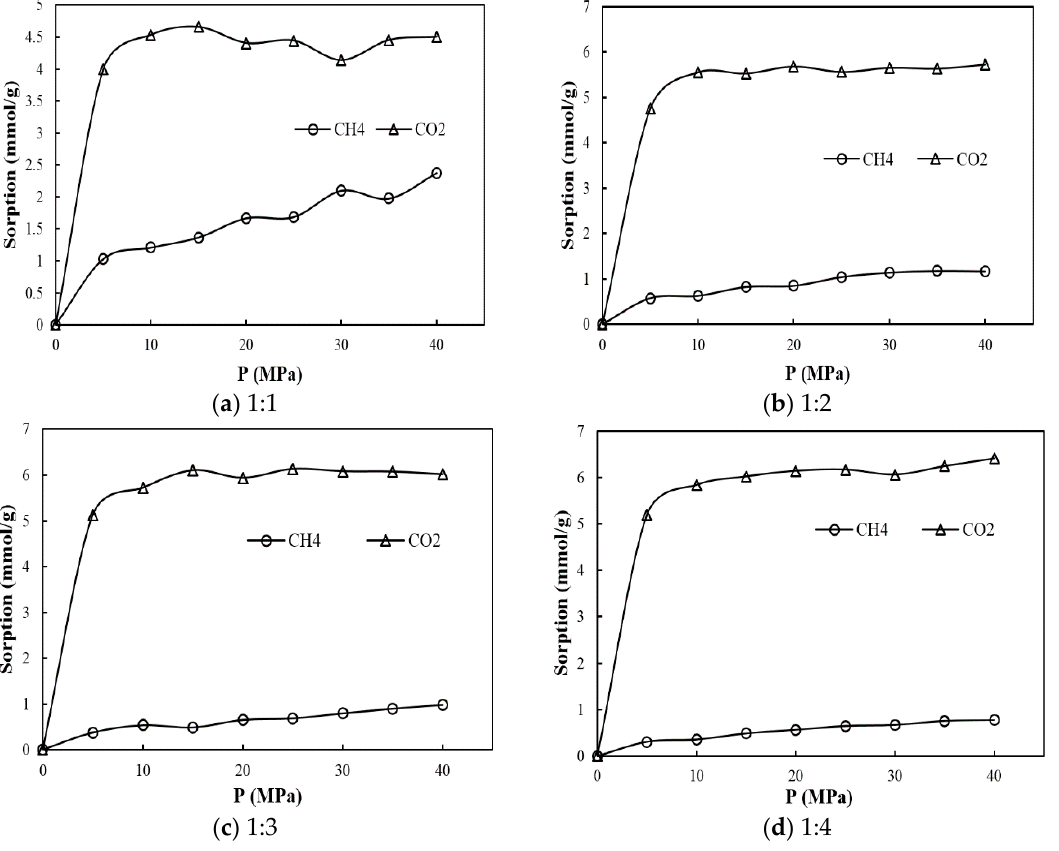
Figure 5. Adsorption isotherms of CH 4 /CO 2 .